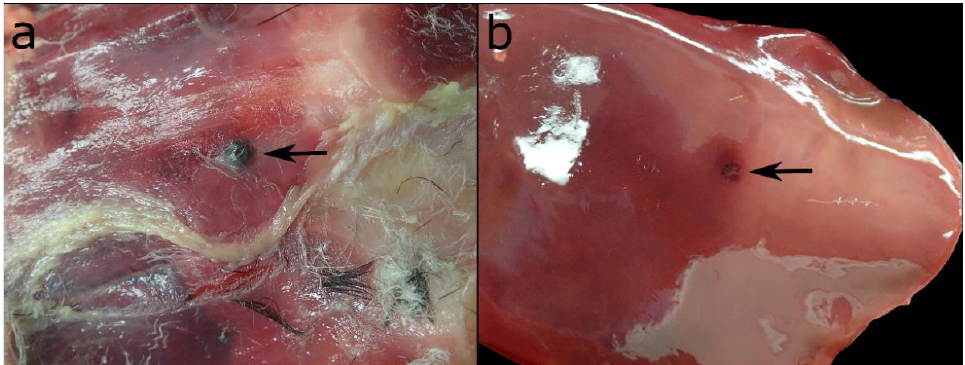
Figure 3. ( a ) Gunshot pellet in the subcutis of the abdomen with ( b ) a focal, superficial impression on on the liver tissue of the same bird. the liver tissue of the same